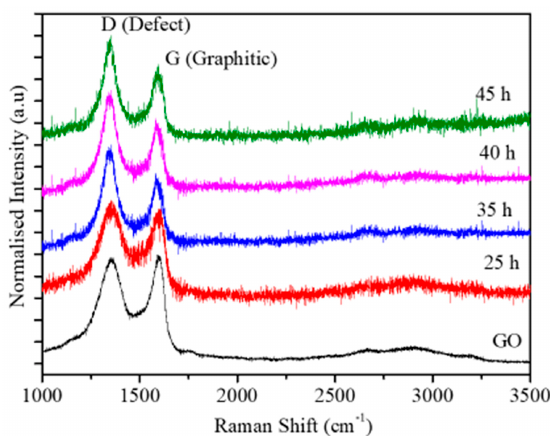
Figure 2. Raman spectra obtained from pure GO and GO-Fe nanocomposite with composition 50:50 milled for 25, 35, 40, and 45 h.